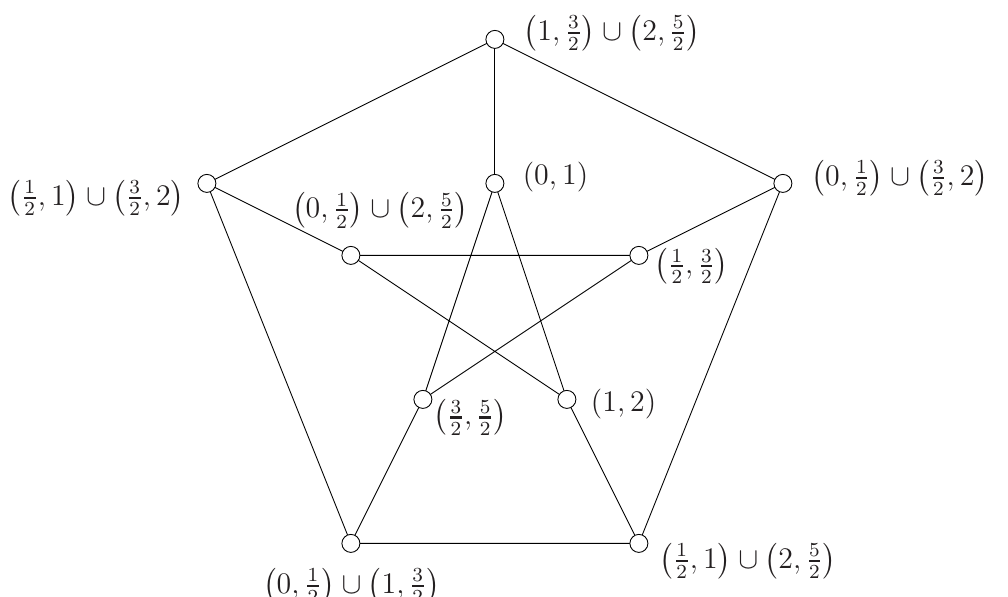
) and each meeting 2